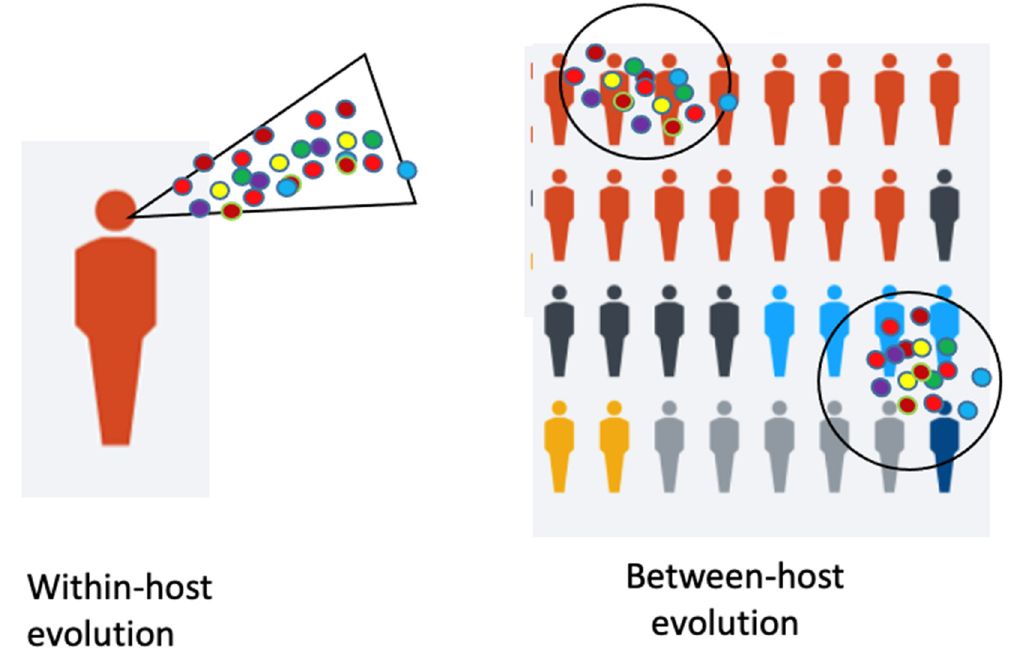
Figure 1. Legend. Within-host and Between-host evolution. De novo mutations of viruses may arise in individual hosts and can become pandemic (modified from [18]).